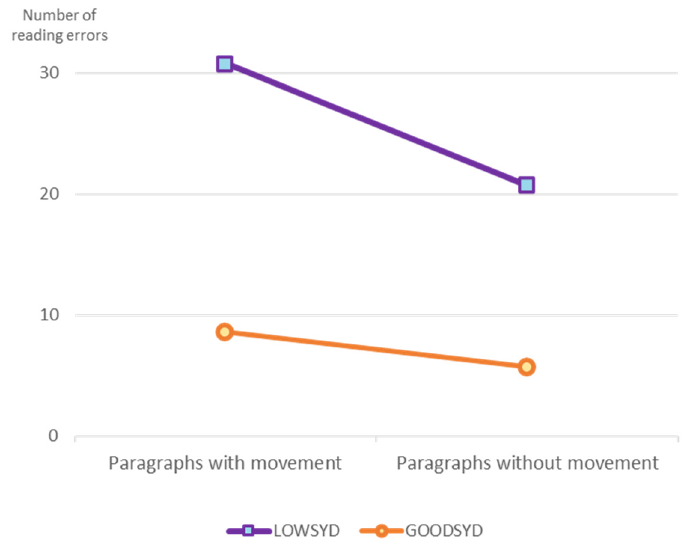
Figure 3. Reading errors: The interaction between group of DHH children, with or without syntactic impairment, and type of paragraph, with or without syntactic movement.